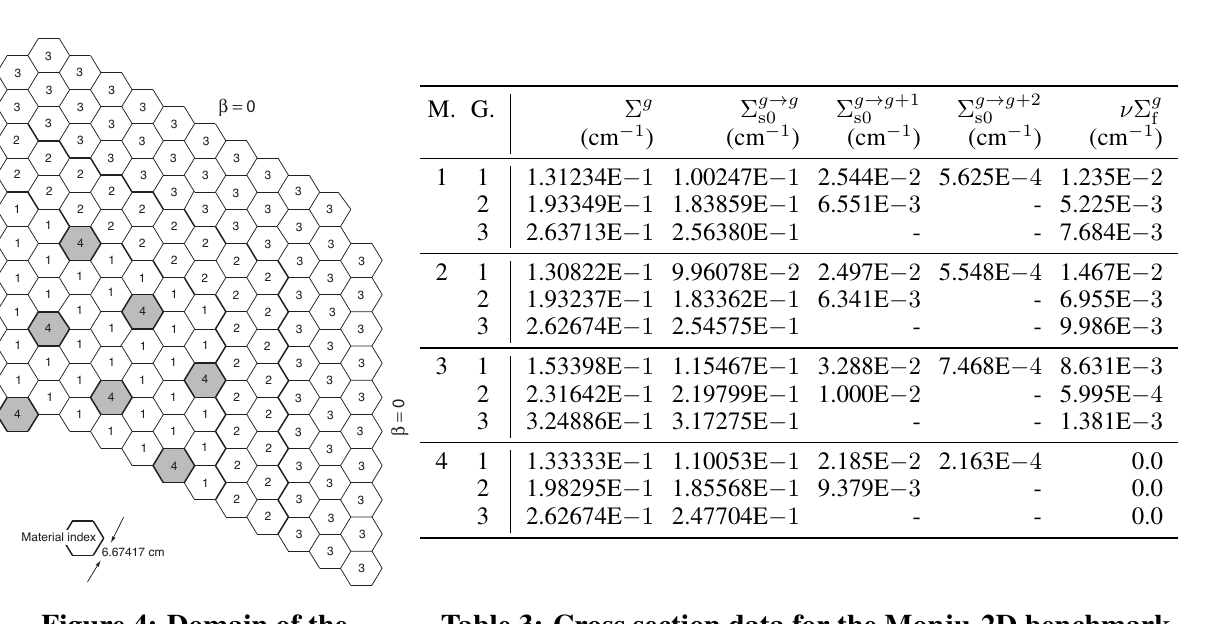
Figure 4: Domain of the Table 3: Cross section data for the Monju-2D benchmark Monju-2D benchmark. shown in Fig. 4. M. denotes the material Mixture, and G. the Hexagon side is 6.67417 cm. energy